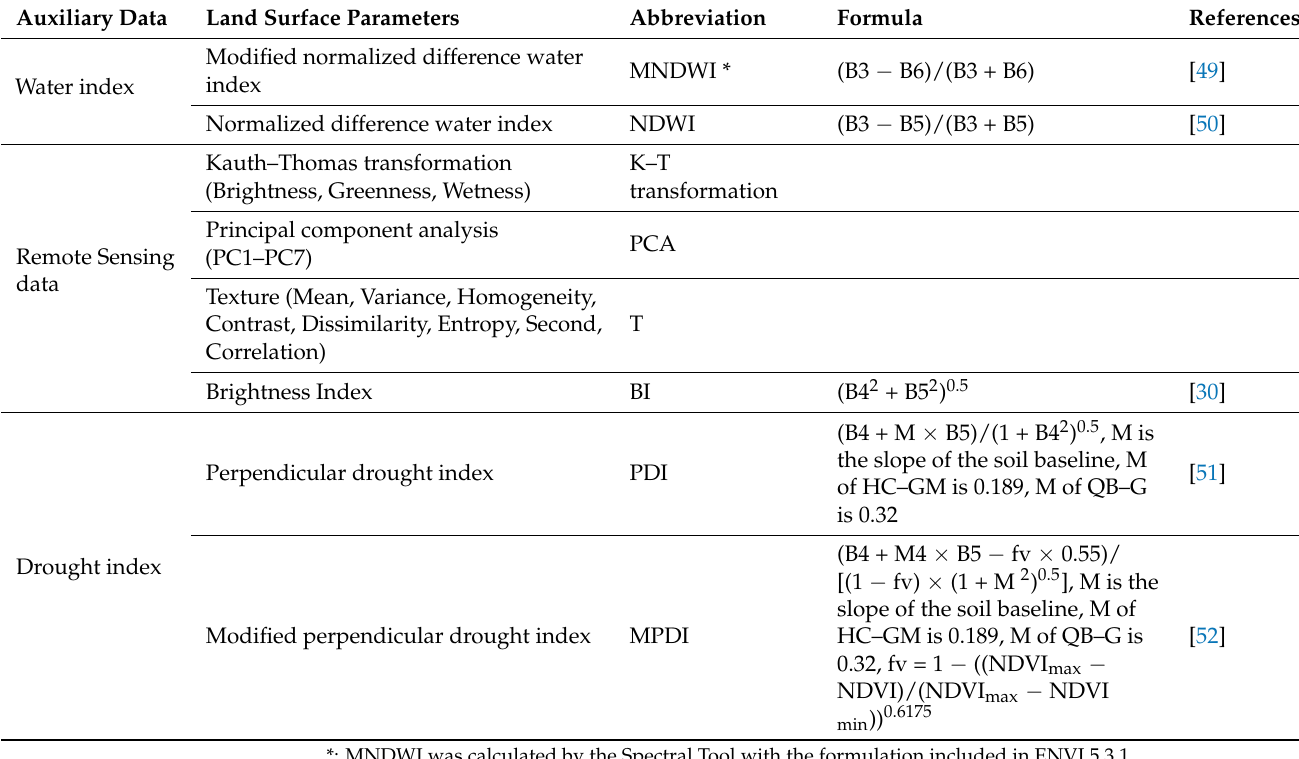
Table 3. Water indexes, drought indexes and remote sensing data required for the model.